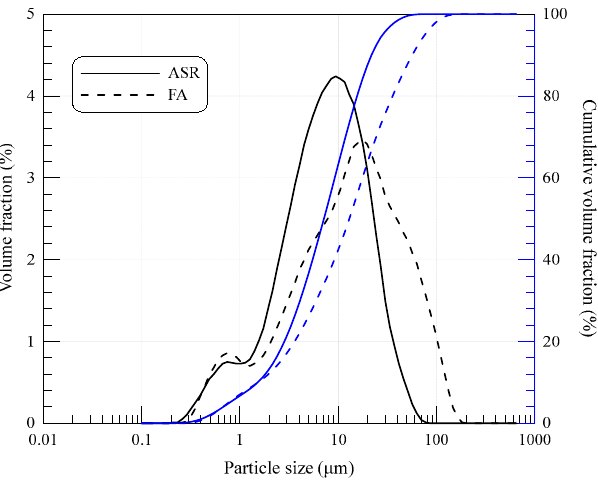
Figure 3. Particle size distribution of ASR and FA. Table 2. Mix proportions of MOC pastes with and without